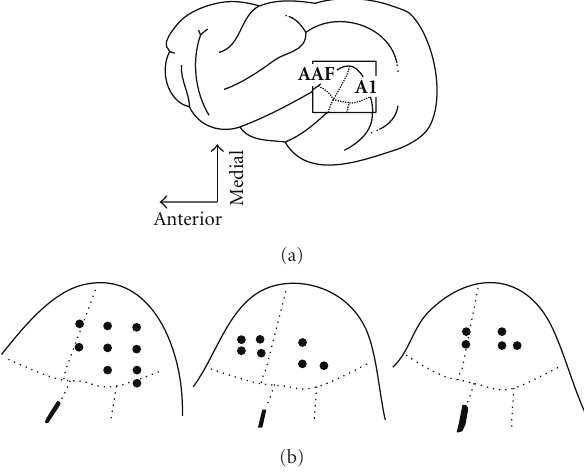
Figure 2: Single-unit recording penetrations in core (AAF and A1) auditory cortex of the three ferrets with early hearing loss. Part (a) shows a lateral view of the ferret cortex with the location of the core auditory areas of anterior auditory field (AAF) and primary auditory cortex (A1) indicated (boxed). Part (b) shows tracings of surface photographs of the positions of the recording penetrations ( n = 21) made in each of the hearing impaired animals. Dotted lines approximate the borders of the auditory fields (after